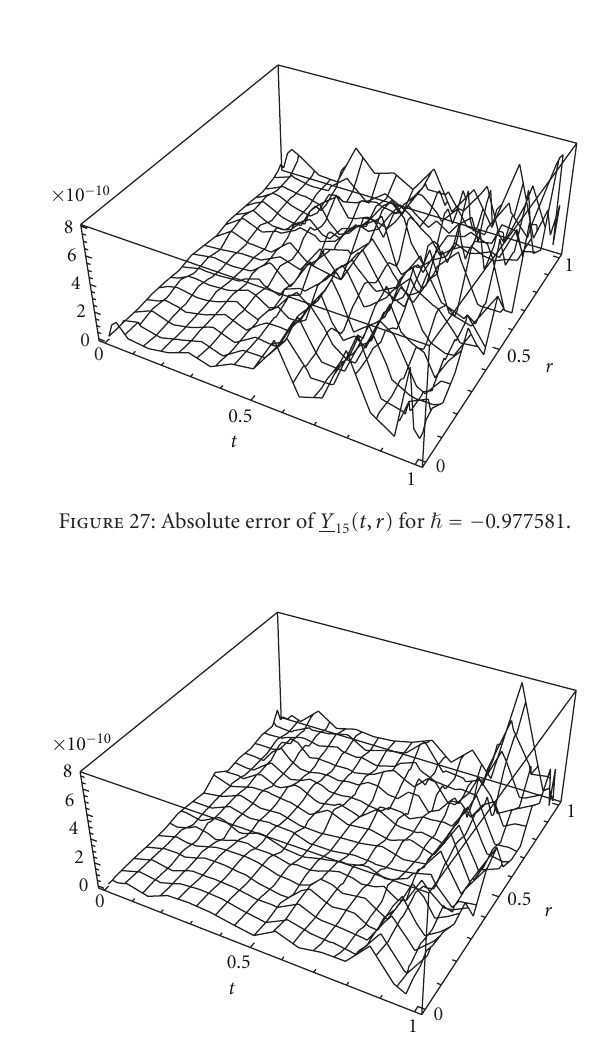
Figure 28: Absolute error of Y 15 ( t , r ) for (cid:2) = − 0 .